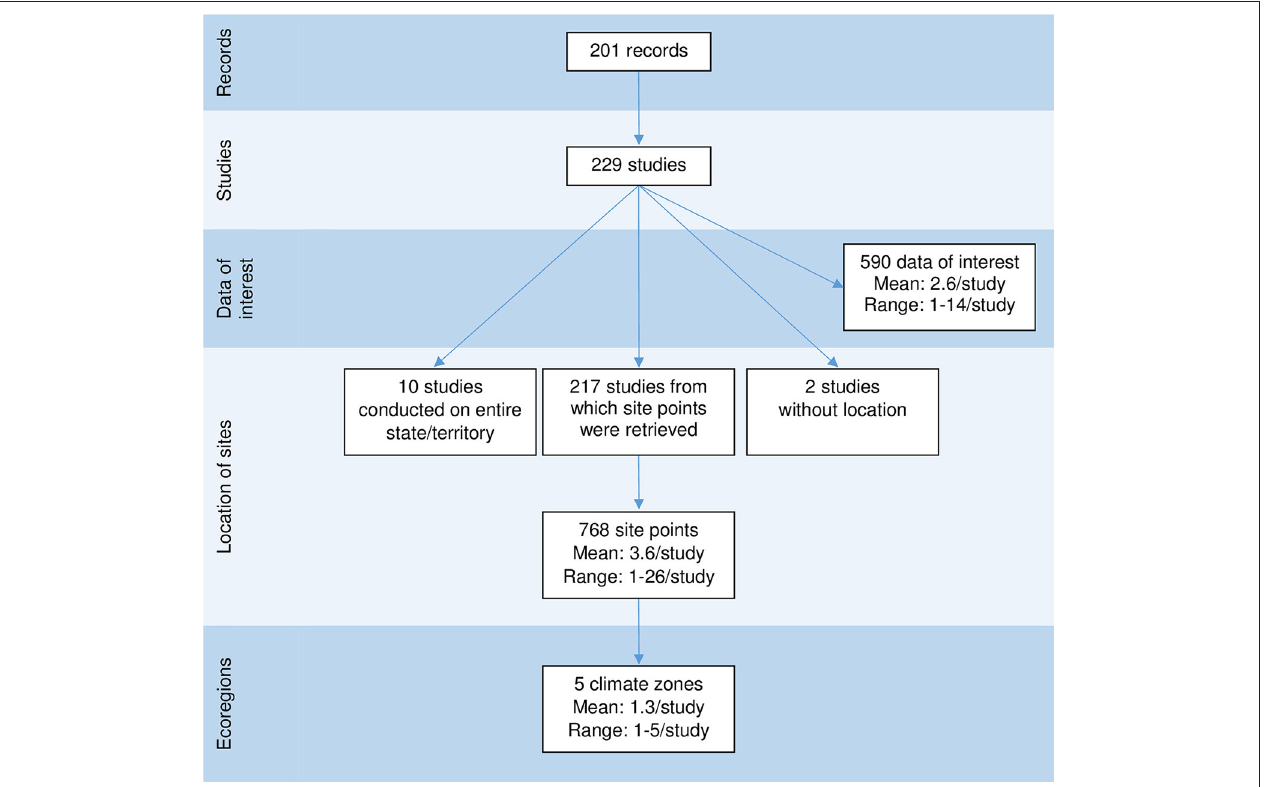
FIGURE 2 | Diagram illustrating the links between the number of records, studies, data of interest, site points, and ecoregions, captured in a scoping review on the ecology and biology of dingoes, feral domestic dogs, and dingo-dog hybrids in Australia, targeting 28 specific topics of interest selected to inform disease spread